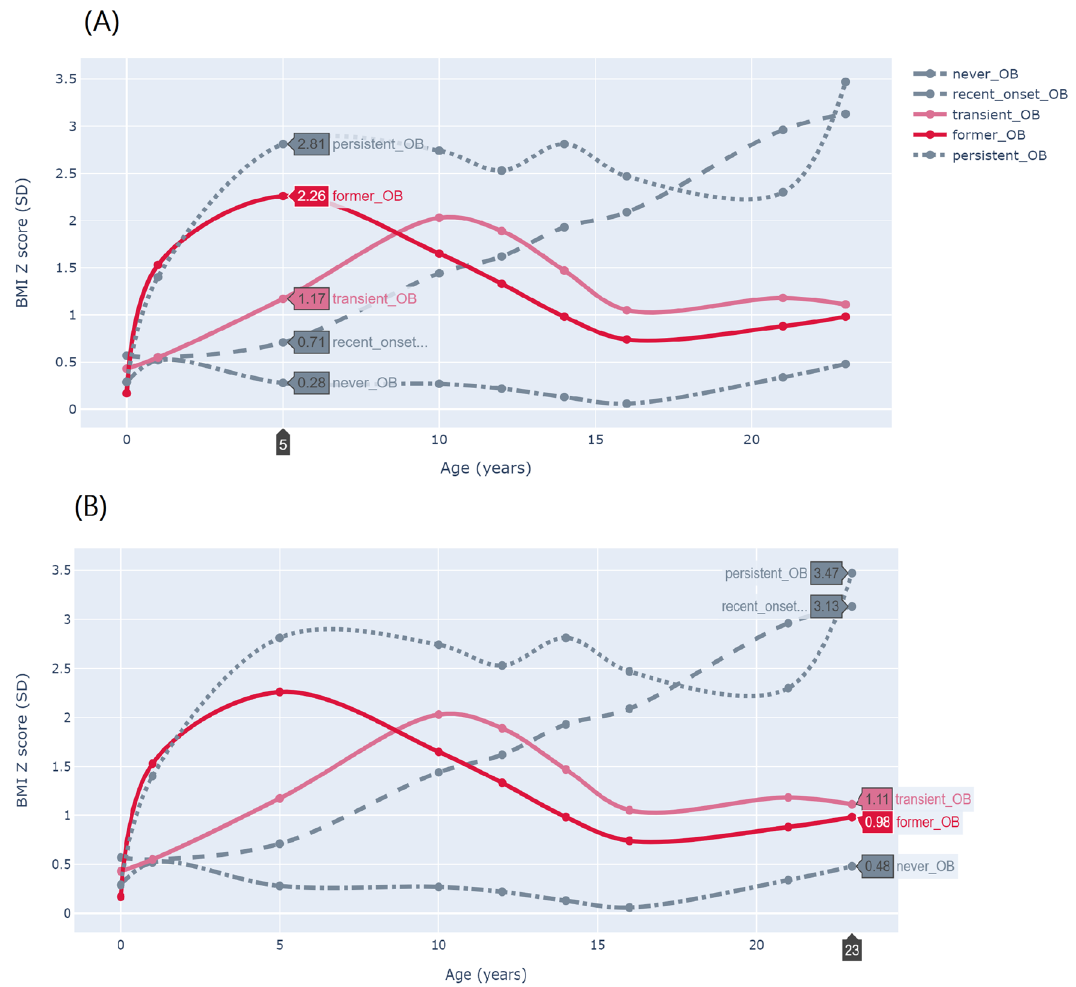
Figure 1. BMI trajectory from birth to adulthood in the Santiago Longitudinal Study (n = 1039). Participants who were never obese (never-OBs); participants with obesity starting in adolescence and remained obese into adulthood (recent-onset-OBs); participants who were obese in early childhood but transitioned to non-obesity as preadolescents (former-OBs); participants who were obese in early childhood and remained obese into adulthood (persistent-OBs); and participants with obesity starting in preadolescence and transitioned to non- obesity as adolescents (transient-OBs). BMI was measured at birth, 1 years, 5 years, 10 years, 12 years, 14 years, 16 years and 23 years. Trajectories were interpolated using cubic spline. This method gives an interpolating polynomial that is smoother and has smaller error than other interpolating polynomials (e.g., Lagrange and Newton polynomials). Panel ( A ) draws attention to BMI-for-age-and-sex at 5y, whereas panel ( B ) does at 23 years. Trajectories of participants that solved obesity are shown in pink (transient-OBs) and red (former-OBs) shades. Note: This figure was partially taken from Burrows et al. 42